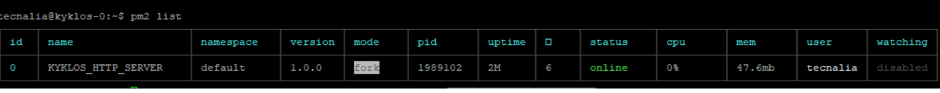
Figure 8. Node.js application from the validation experiment.